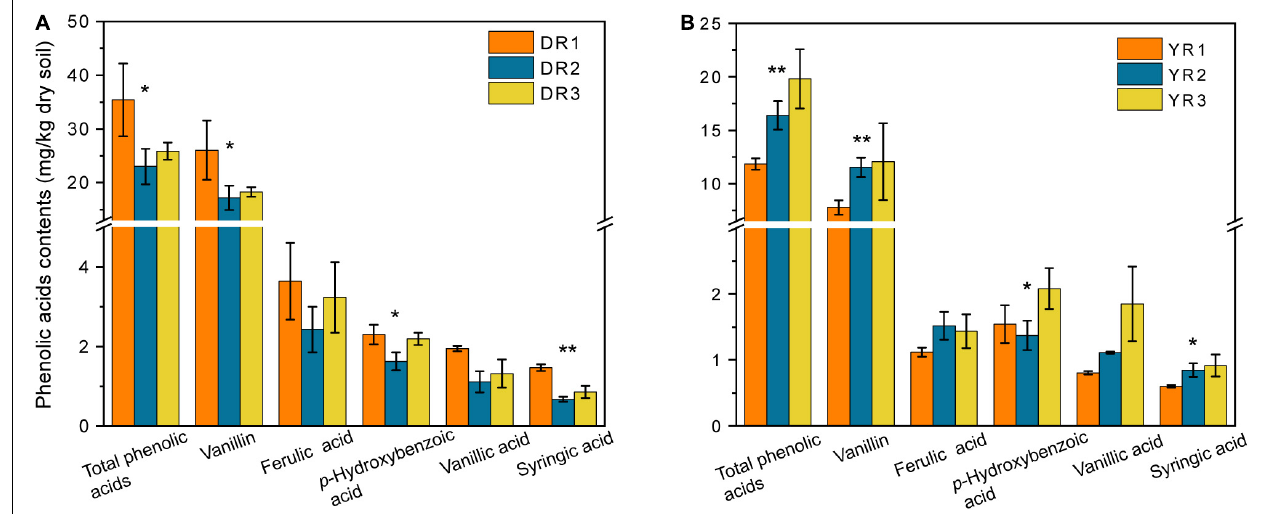
FIGURE 3 | The phenolic acid contents in the rhizosphere soil from Dali (A) and Yuxi (B) . Values are the average of three replicates with a standard deviation bar. DR1, DR2, and DR3 represent the rhizosphere soil in non-, slightly, and severely diseased groups from Dali, respectively. YR1, YR2, and YR3 represent the corresponding samples from Yuxi. “**” and “*” represent the contents of the phenolic acids showing extremely significant ( p < 0.01) and significant ( p < 0.05) difference, respectively.